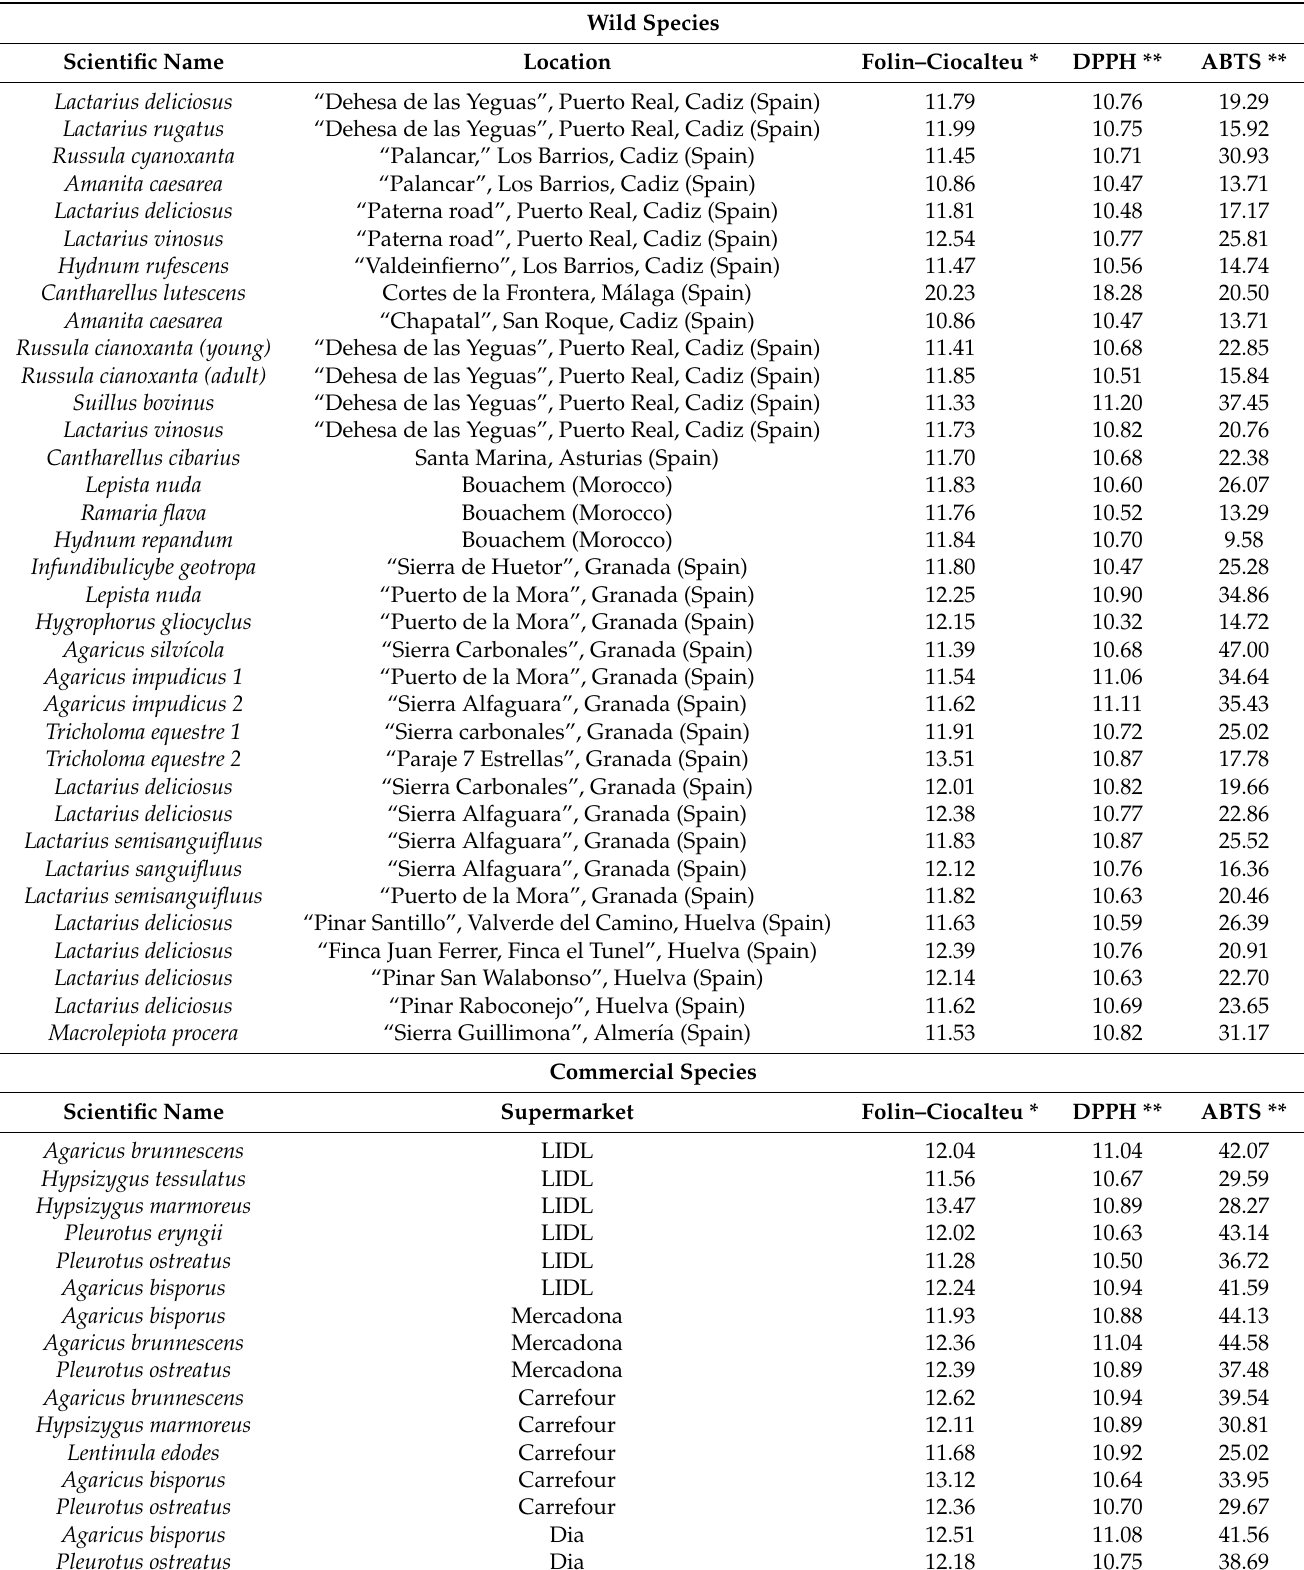
Table 5. Results from applying the developed method to wild and commercial mushroom samples. Wild